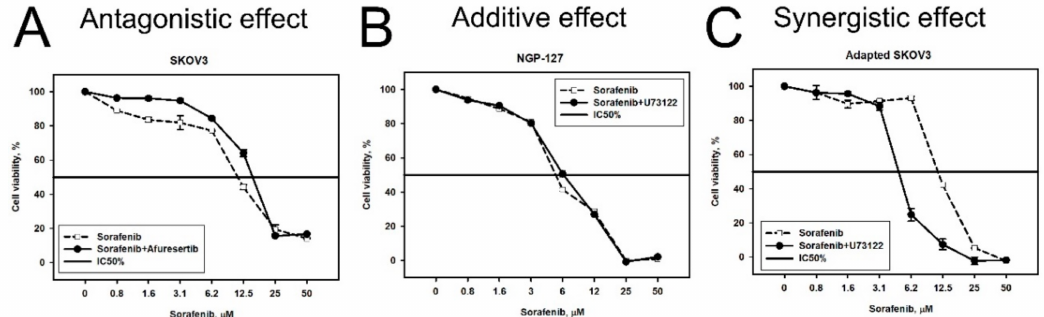
Figure 4. Examples of antagonistic ( A ), additive ( B ), and synergistic ( C ) effect of inhibitor/drug combinations. Dashed line corresponds to single drug, solid line—combination. Survival of cells, subjected to combination of drugs was normalized by viability of cells, treated with the drug used in constant concentration. For example, the viability of SKOV-3 cells subjected to Sorafenib and Afuresertib was divided by viability of SKOV-3 cells subjected to IC 20 of Afuresertib alone. FLI-06 in SKOV-3 cells. Notch protein, molecular target of FLI-06, was predicted to be a potent drug resistance actor for the SKOV-3 cells cultured with Sunitinib, Everolimus, or